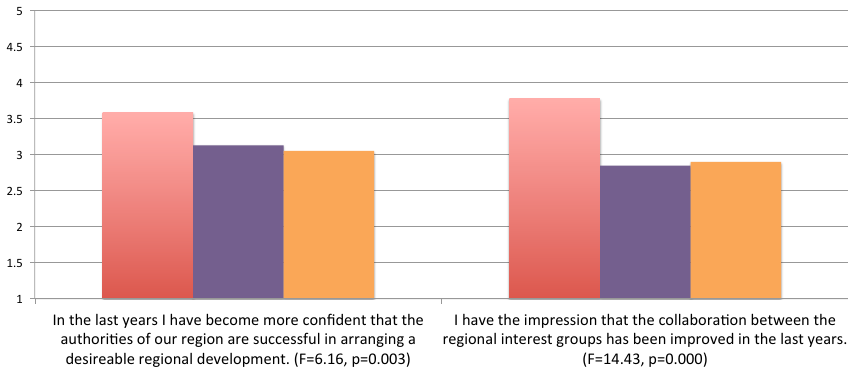
Fig. 3. Swiss inhabitants’ agreement with statements related to their or their region’s network capacities differentiated between groups with and without reported stakeholder involvement in their region. Comparison of mean values (ANOVA). N = 230.